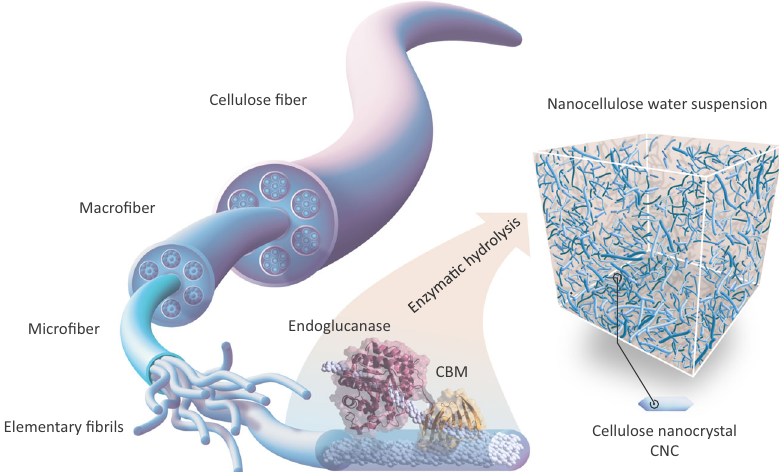
Fig. 1 Illustration of cellulose enzymatic hydrolysis. The hierarchical structure of cellulose fi ber permits its degradation into nano scale particles. Enzymatic hydrolysis was performed in water at 50 °C at different times in agitation with different endoglucanase. Here, we show how endoglucanase with CBM can attach to the cellulose fi ber placing the catalytic domain in the fi ber surface and improving its activity. Enzymes degradation can produce nanocellulose with different sizes depending on the hydrolysis time and enzyme usage. Cellulose nanocrystals (CNC) are small crystalline particles with lengths between 100 and 500 nm and diameters between 3 and 40